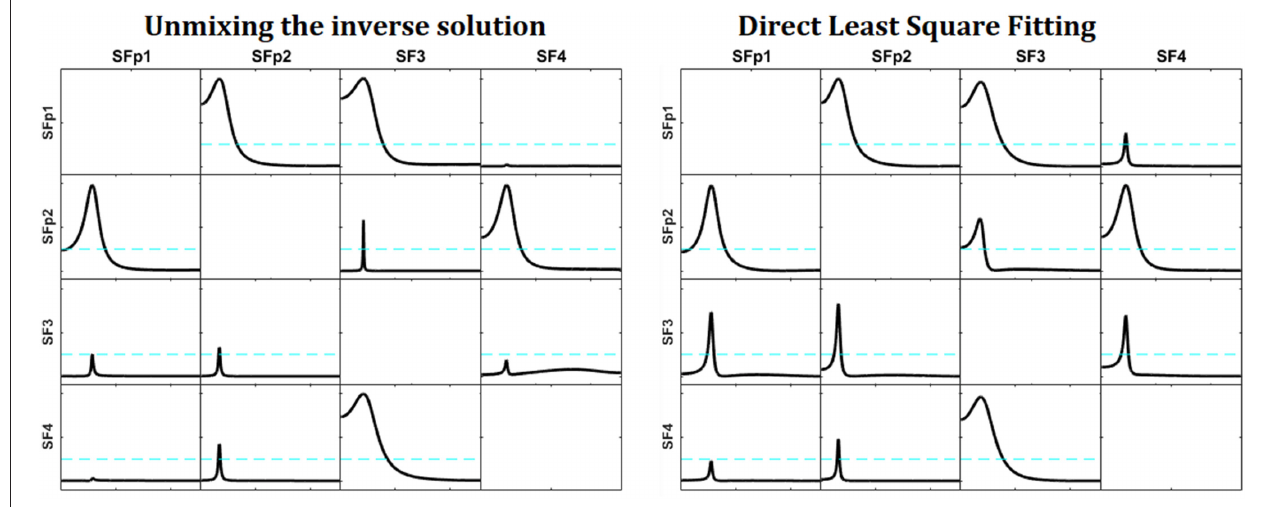
FIGURE 4 | Reconstruction of the patterns of influence for the system simulated in Figure 3 with measurement noise added. At the left, the reconstruction obtained by the unmixing procedure and sLoreta. To the right, the reconstruction obtained by the direct fitting of the model. Note that the reconstruction of the unmixing procedure is less affected by the noise, and very similar to the one obtained in Figure 3 , where the measurement noise was not added.